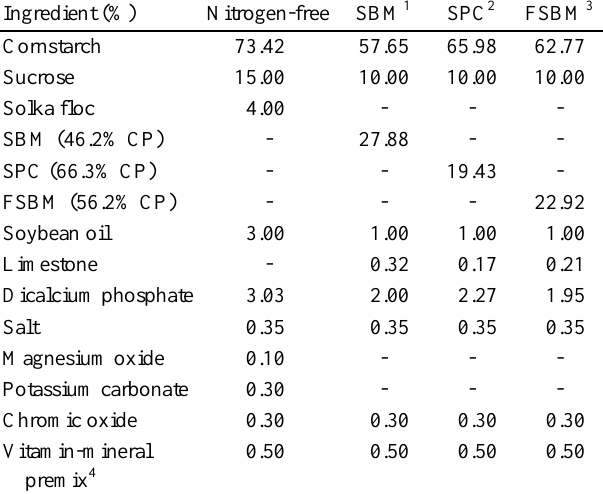
Table 3. Ingredient composition of experimental diets containing soybean meal (SBM), soy protein concentrate (SPC) and fermented soybean meal (FSBM) (as-fed basis), Exp. 2 Ingredient (%)